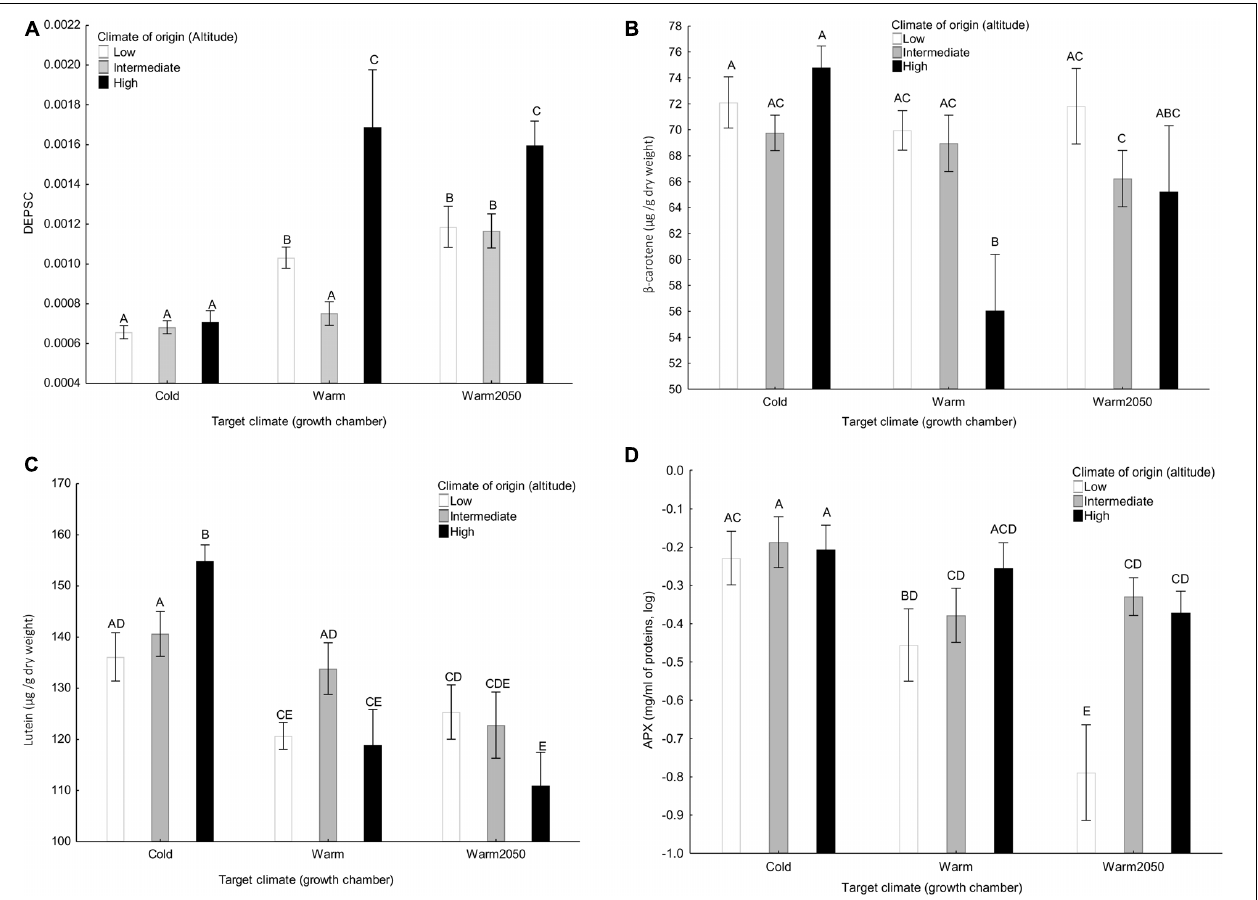
FIGURE 3 | The effect of climate of origin expressed as altitudinal category and target climate (growth chamber) on (A) DEPSC, (B) β -carotene, (C) lutein, and (D) L-ascorbate peroxidase separately in the three target growth chambers. Columns sharing the same letter are not significantly different from each other ( p >